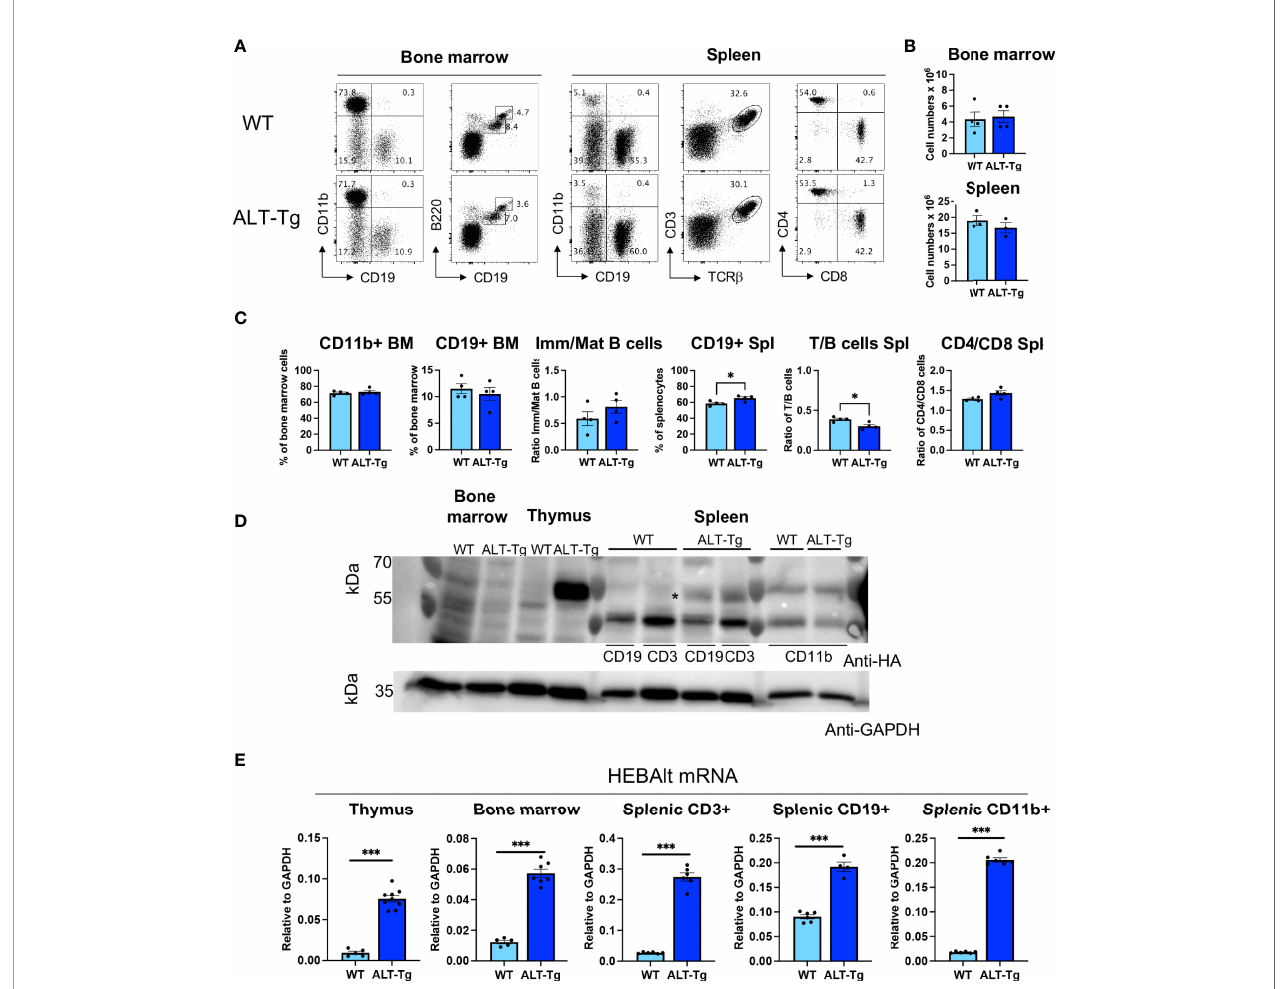
FIGURE 8 | Loss of HEBAlt protein stability in immune cell subsets outside the thymus. A-C. (A) Phenotype, (B) cell numbers, and (C) frequencies or ratios of T cell, B cell, and myeloid subsets in bone marrow and spleen of WT (light blue) and ALT-Tg (dark blue) mice. The bone marrow B220/CD19 plot is gated on CD19+ cells, and the spleen CD4/CD8 plot is gated on CD3+ cells. (D) Western blot analysis of transgene-derived HEBAlt-HA protein as detected by anti-HA in WT or ALT-Tg bone marrow, thymocytes, or sorted splenic T (CD3), B (CD19), and myeloid (CD11b) cells. GAPDH is shown as a loading control. The star pinpoints a band that is present in the ALT-Tg splenic T and B cells but not in the WT cells or myeloid cells. (E) Expression of total HEBAlt levels in thymus, bone marrow, and splenic T, B, and myeloid cells from WT and ALT-Tg mice, as analyzed by qRT-PCR and normalized to GAPDH, showing that there are higher levels of HEBAlt mRNA in these populations than in WT mice, despite the paucity of transgene-derived HEBAlt protein. *P < 0.05, ***P <